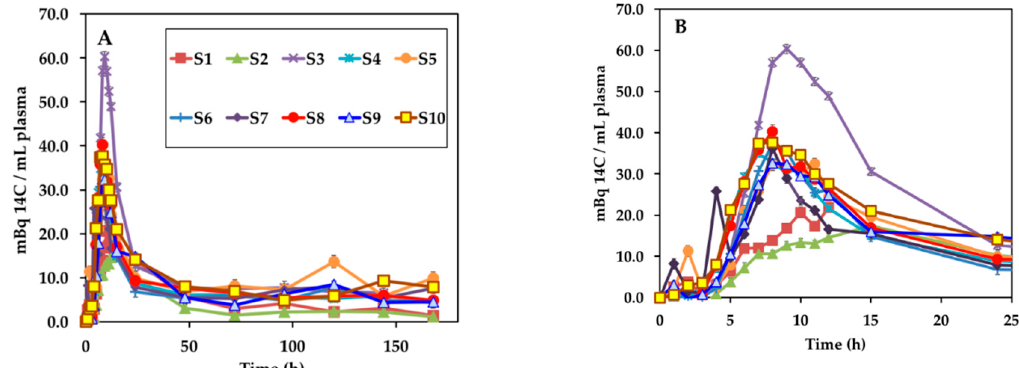
Figure 3. Time course of 14 C-B12 in plasma after ingestion of in vivo labeled egg ( A ) for the entire study, and ( B ) for the initial 24 h. The error bars for individual data points are 1 SD and generally smaller than the symbol.